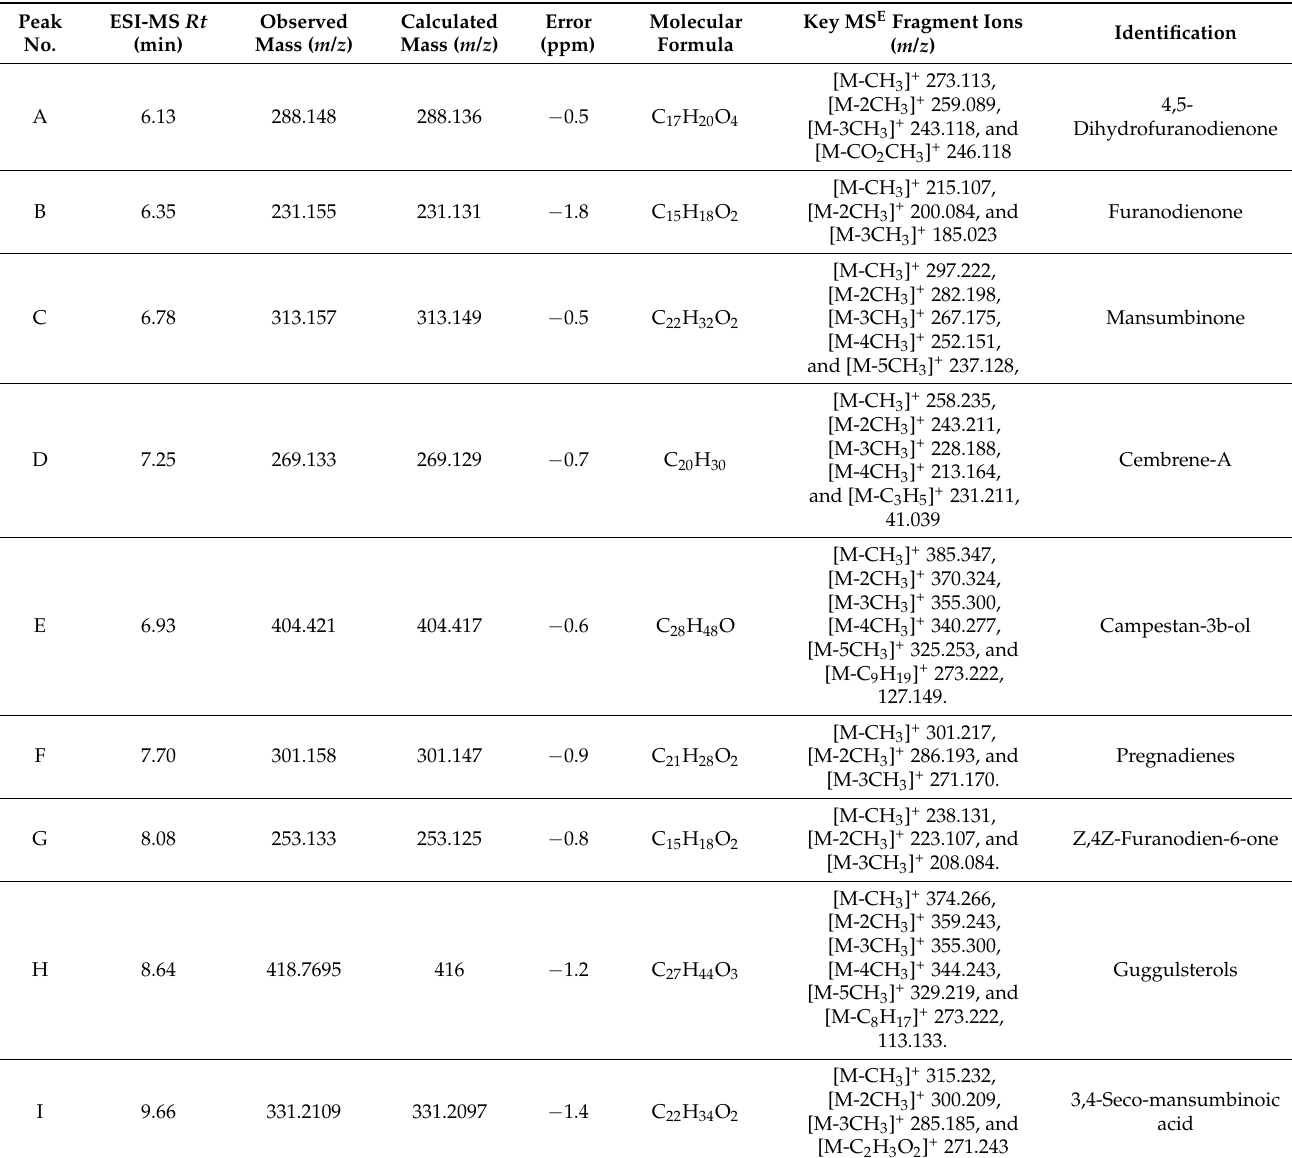
Table 1. Characterization and identification of metabolites found in myrrh methanolic extract using high-performance liquid chromatography time-of-flight mass spectrometry (HPLC/DAD-QTOF